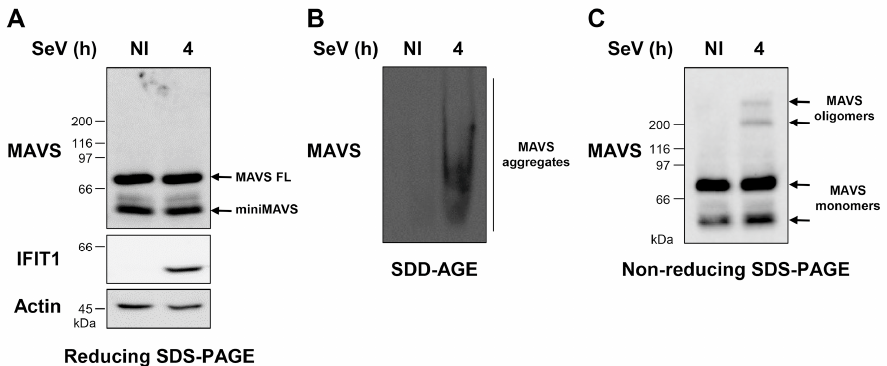
Figure 1. Detection of endogenous mitochondrial antiviral signaling (MAVS) protein aggregates and oligomers induced upon Sendai virus (SeV) infection. ( A – C ) A549 cells were infected with SeV at 10 HAU/10 6 cells for 4 h. Preparation of whole cell extract (WCE) was performed immediately after harvesting. In ( A ) and ( C ), WCEs were subjected to SDS-PAGE after denaturation in SDS loading buffer with ( A ) or without ( C ) BME. Proteins were detected by immunoblot using anti-MAVS, anti-IFIT1, and anti-actin antibodies. In ( B ), WCEs were resolved by semi-denaturing detergent agarose gel electrophoresis (SDD-AGE) and analyzed by immunoblot using anti-MAVS antibodies.